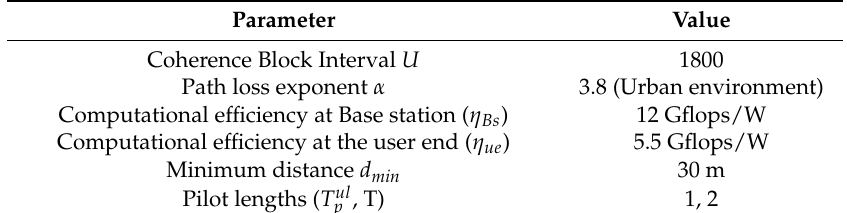
Table 3. Simulation Parameters.